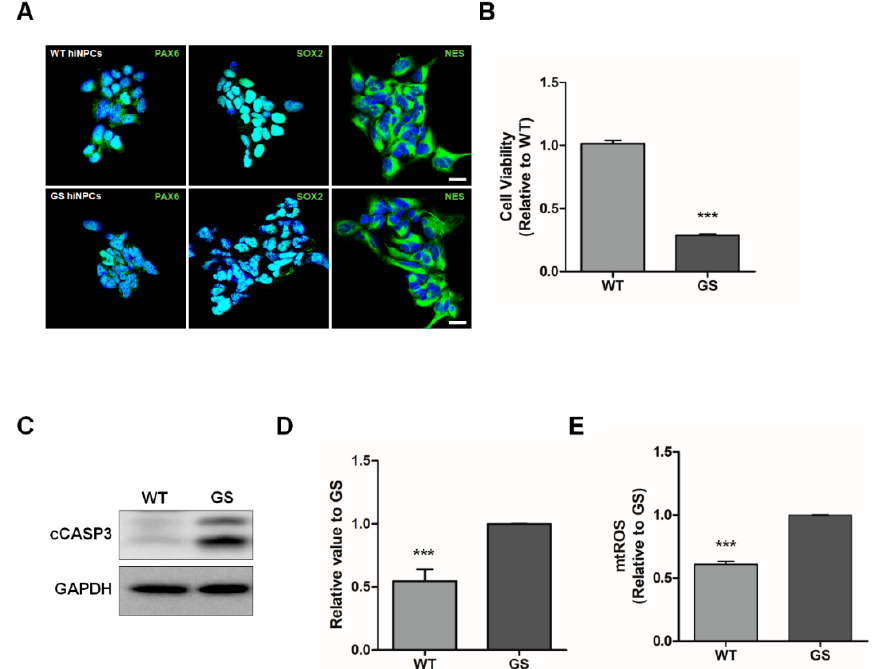
Figure 1. Parkinson’s disease (PD) modeling using patient-derived human-induced neuronal progenitor cells (hiNPCs). ( A ) Immunostaining of neural progenitor cell markers in hiNPCs (scale bars are 20 µ m). ( B ) Cell viability assay with MG132 treatment. ( C ) Representative Western blot for cleaved caspase-3 (cCASP3) in hiNPCs treated with MG132. Glyceraldehyde 3-phosphate dehydrogenase (GAPDH) was used as an internal control. ( D ) Quantification of cCASP3 normalized over GAPDH by densitometry analysis. ( E ) Mitochondrial reactive oxygen species (mtROS) of MG132-treated hiNPCs stained with MitoSOX. WT, healthy control-derived hiNPCs; GS, familial LRRK2 G2019S PD patient-derived hiNPCs. Data are mean ± standard error of means (SEM) of at least three independent experiments. p -values were analyzed using the unpaired two-tailed Student’s t -test (* p < 0.05, ** p < 0.005, *** p < 0.001).